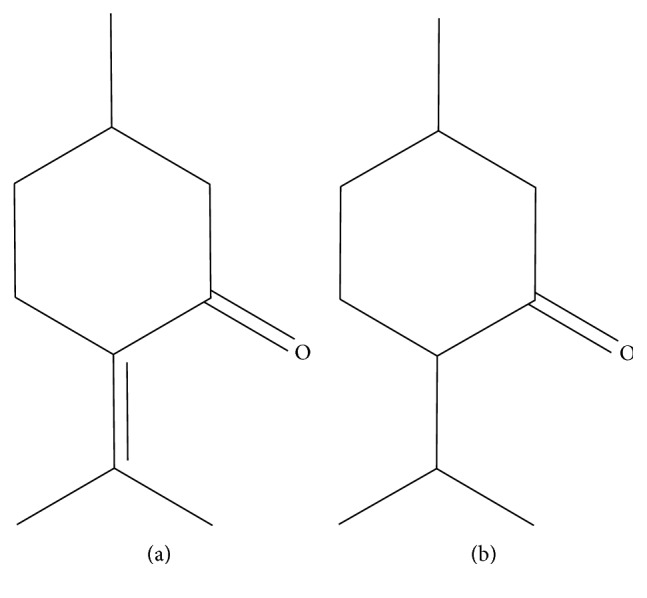
Chemical structure of pulegone (a) and menthone (b).